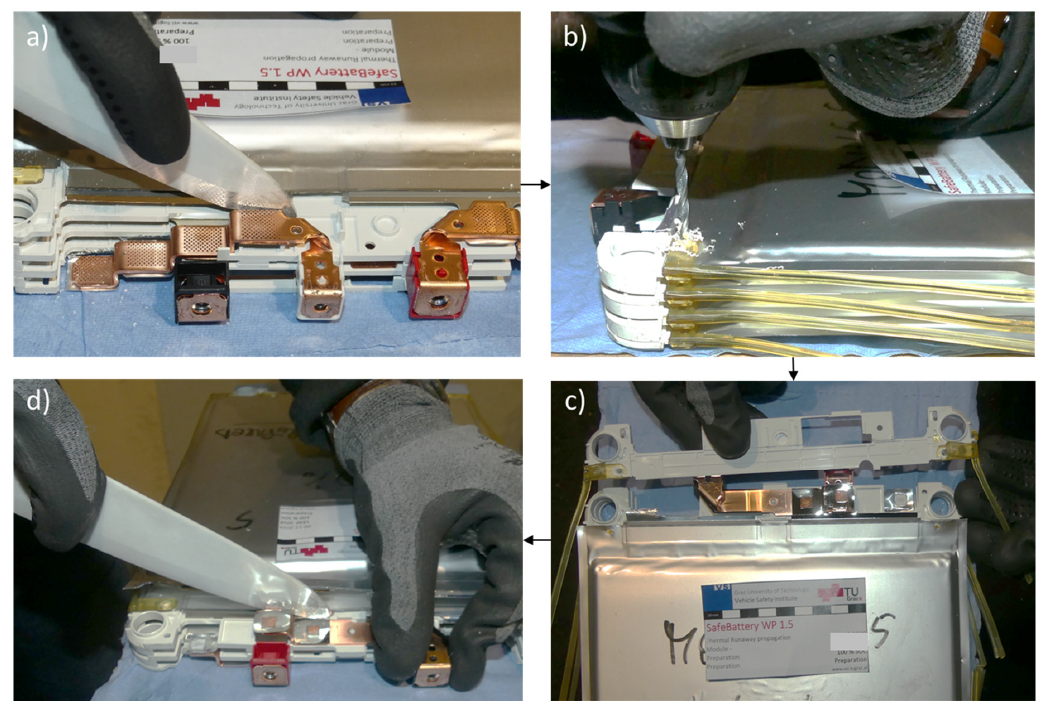
Figure 3. Procedure for partial disassembling of Li-ion cell module. ( a ) First two levels of accessible busbars are removed with a ceramic cutter; ( b ) Resin spots of first two cells are removed with a 3 mm drill bit; ( c ) Plastic frames are removed uncovering next busbars layers; ( d ) Procedure is repeated for further busbars layers.